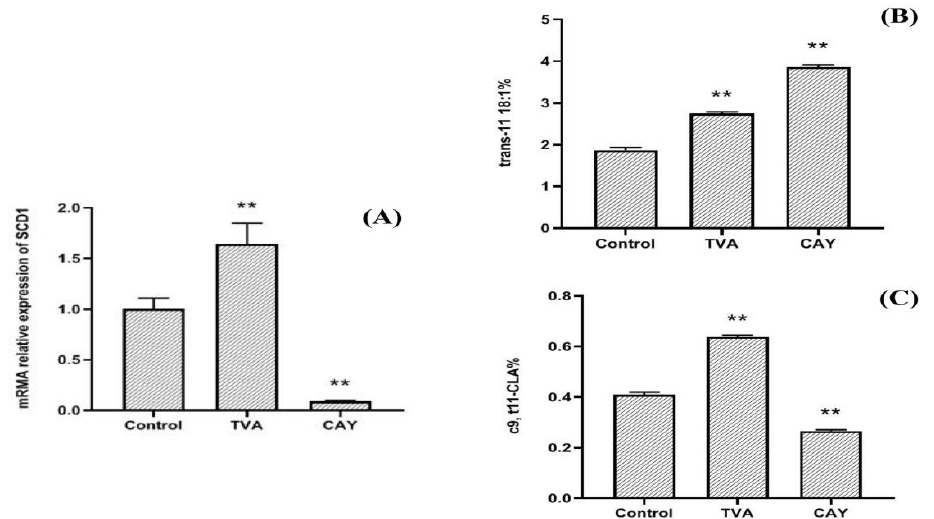
Figure 1. The SCD1 mRNA relative expression ( A ); TVA accumulation ( B ); % of total identified fatty acids) and c9, t11-CLA synthesis ( C ); % of total identified fatty acids in MAC-T cells under different incubation conditions. CAY group (SCD1-inhibited MAC- T cells model): incubated with 50 μM TVA for 2.5 h after CAY10566 treatment at concentrations of 10 nM for 12 h, TVA group: only incu- bated with 50 μM TVA for 2.5 h, and control group: without CAY, TVA. ** p < 0.01.